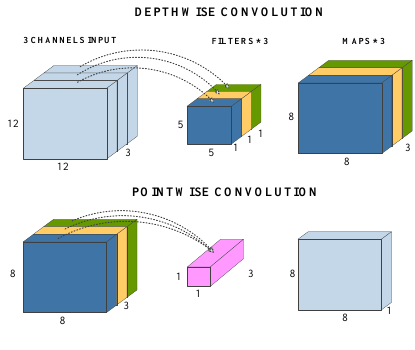
Figure 2. Depthwise Separable Convolution